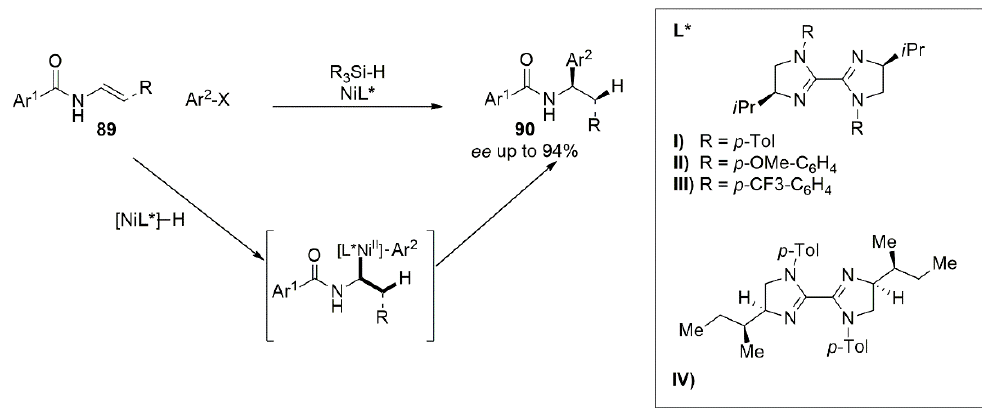
Figure 37 . Bis-imidazoline-Nickel complex employed to synthesize enantioenriched α -arylben- Figure 37. Bis-imidazoline-Nickel complex employed to synthesize enantioenriched α - zamides ( 90 ). arylbenzamides ( 90 ).